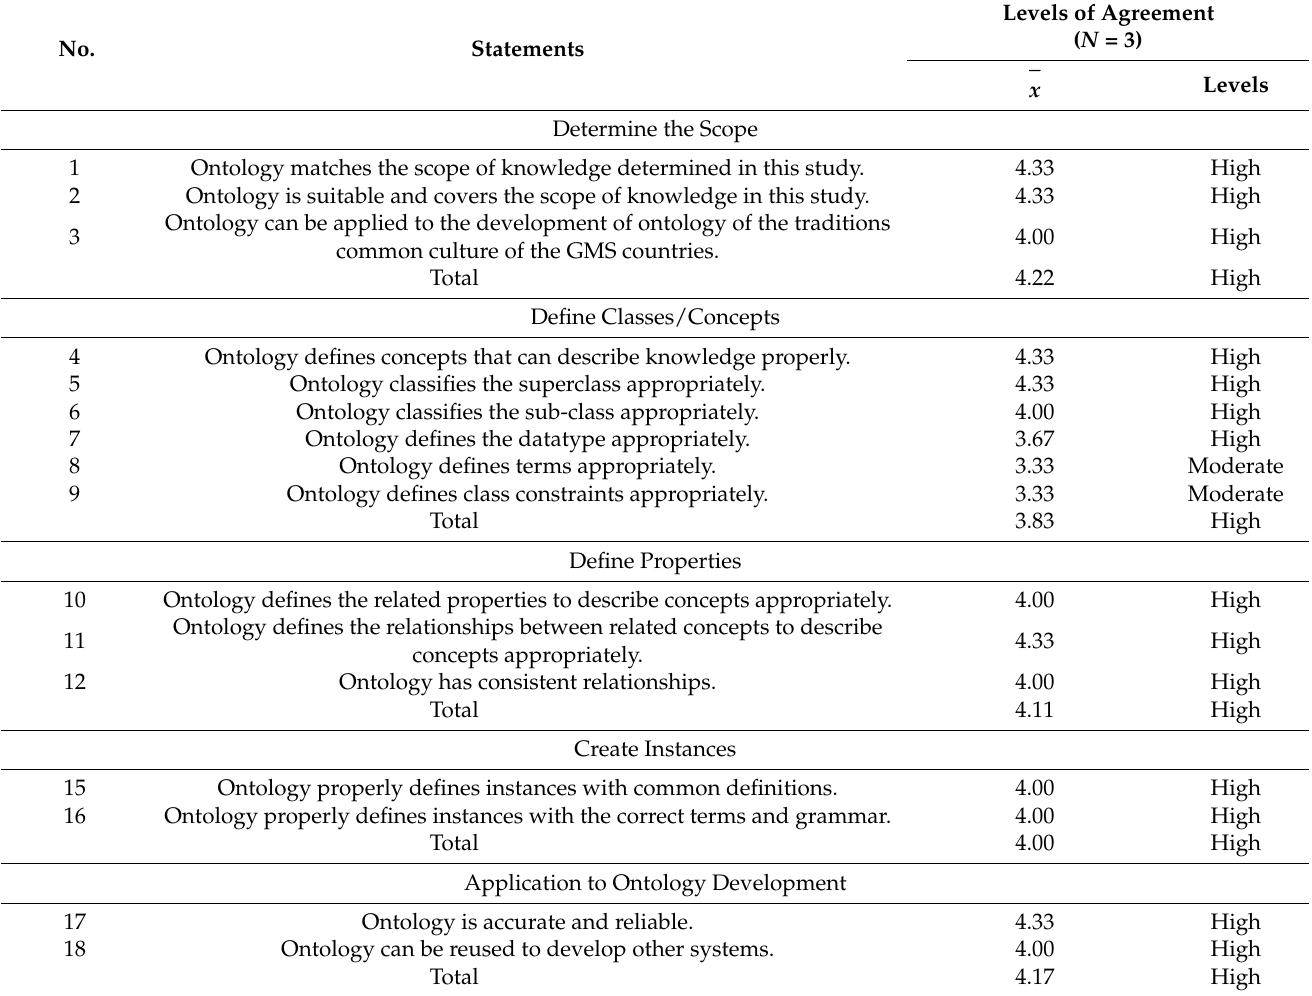
Table 3. The evaluation of traditions common culture of countries in the Greater Mekong Subregion ontology results by experts.